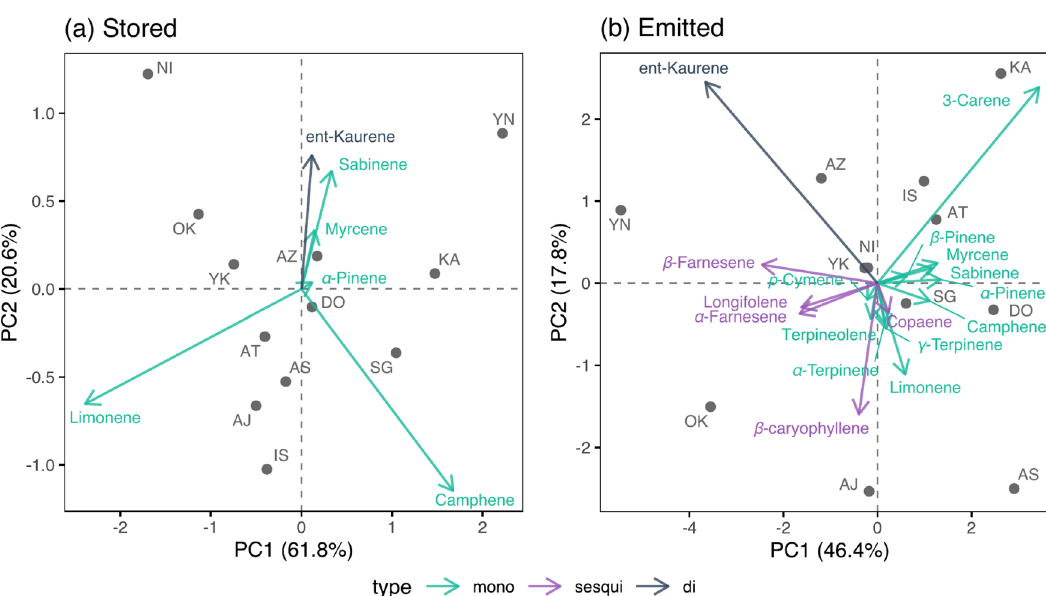
Figure 3. Principal component analysis of stored ( a ) and emitted ( b ) terpenes for each population. Populations at Pacific Ocean side, southwest populations, and Japan Sea side were segragated for emitted